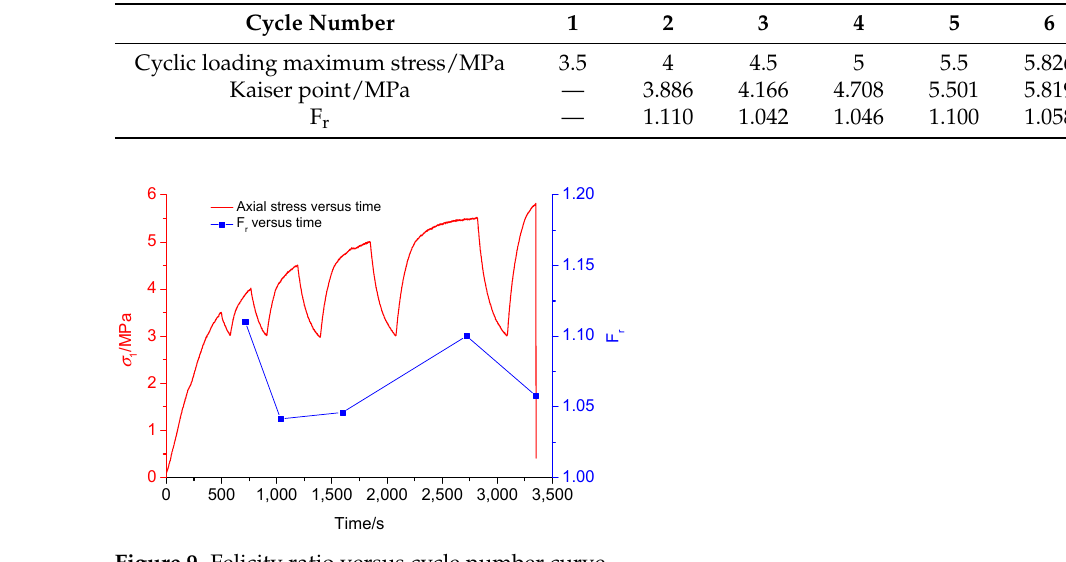
Figure 9. Felicity ratio versus cycle number curve.